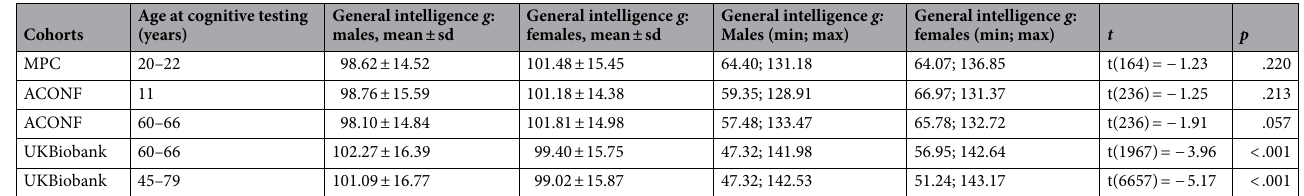
Table 4. Differences in general intelligence g between sexes for all data sets: the Indian sample (MPC), Scottish (ACONF) and UK